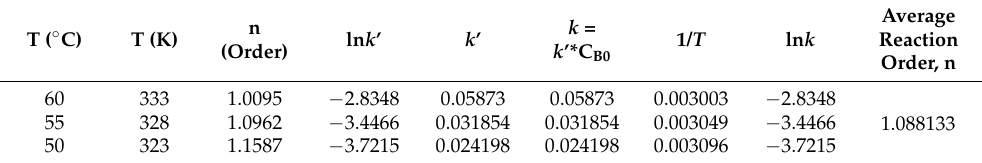
Table 4. 1/T vs. lnk graph for the WCO transesterification process kinetics.